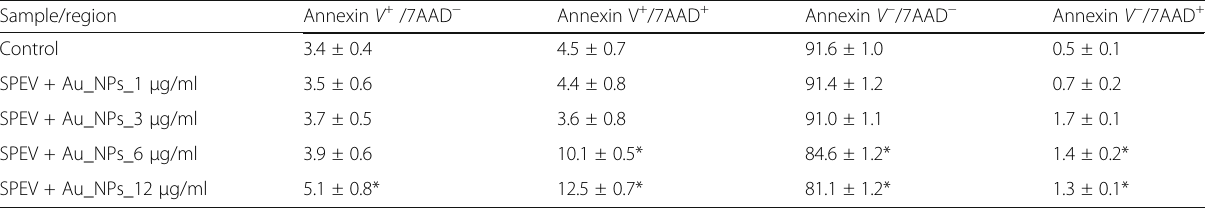
Table 1 Cytofluorimetric analysis of SPEV cells after 4 days culturing with AuNPs, staining with Annexin V and 7AAD Sample/region